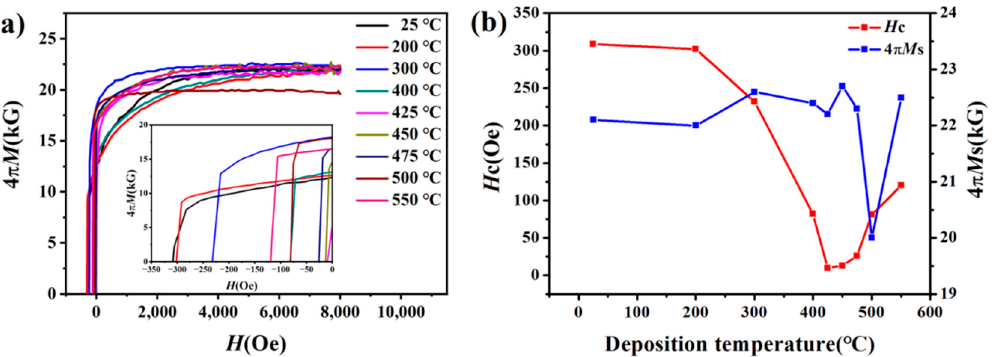
Figure 11. ( a ) Demagnetization curves of FeCo films with thickness of 50 nm deposited at different temperatures, and ( b ) dependence of the coercivity and saturation magnetization on deposition temperature.